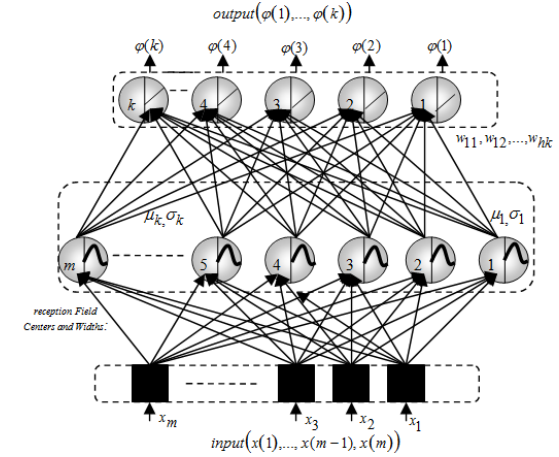
FIGURE 17. A sample three-layer RBF neural